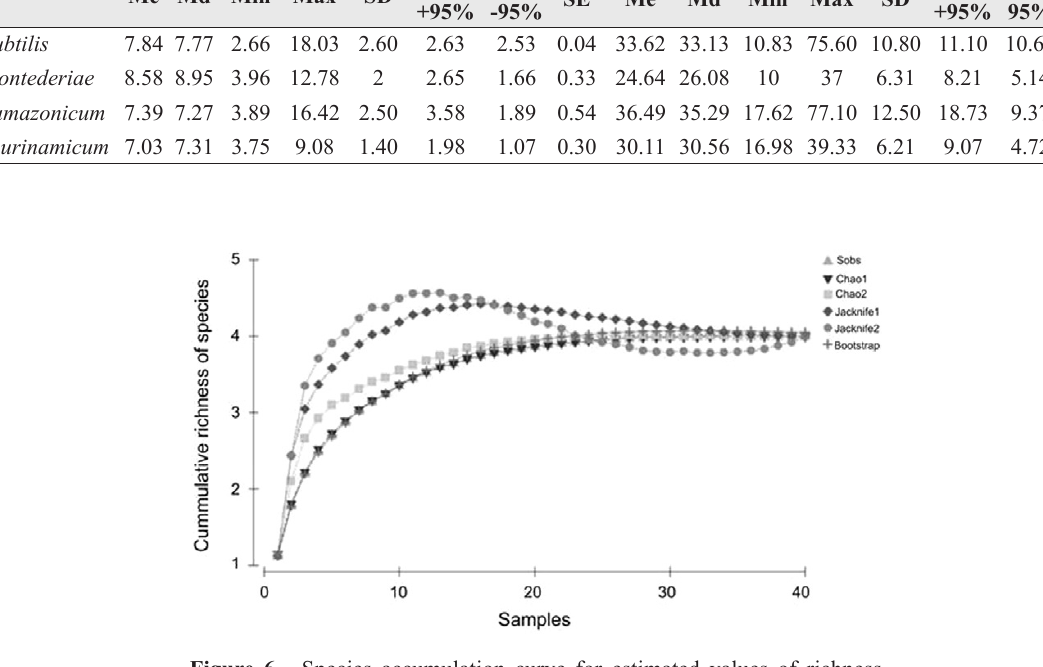
Figure 6 - Species accumulation curve for estimated values of richness (Sobs, Chao1, Chao2, Jacknife1, Jacknife2, and Bootstrap) in tide pools of Areuá Beach, Guarás Island, Curuçá, State of Pará, Brazilian Amazon.